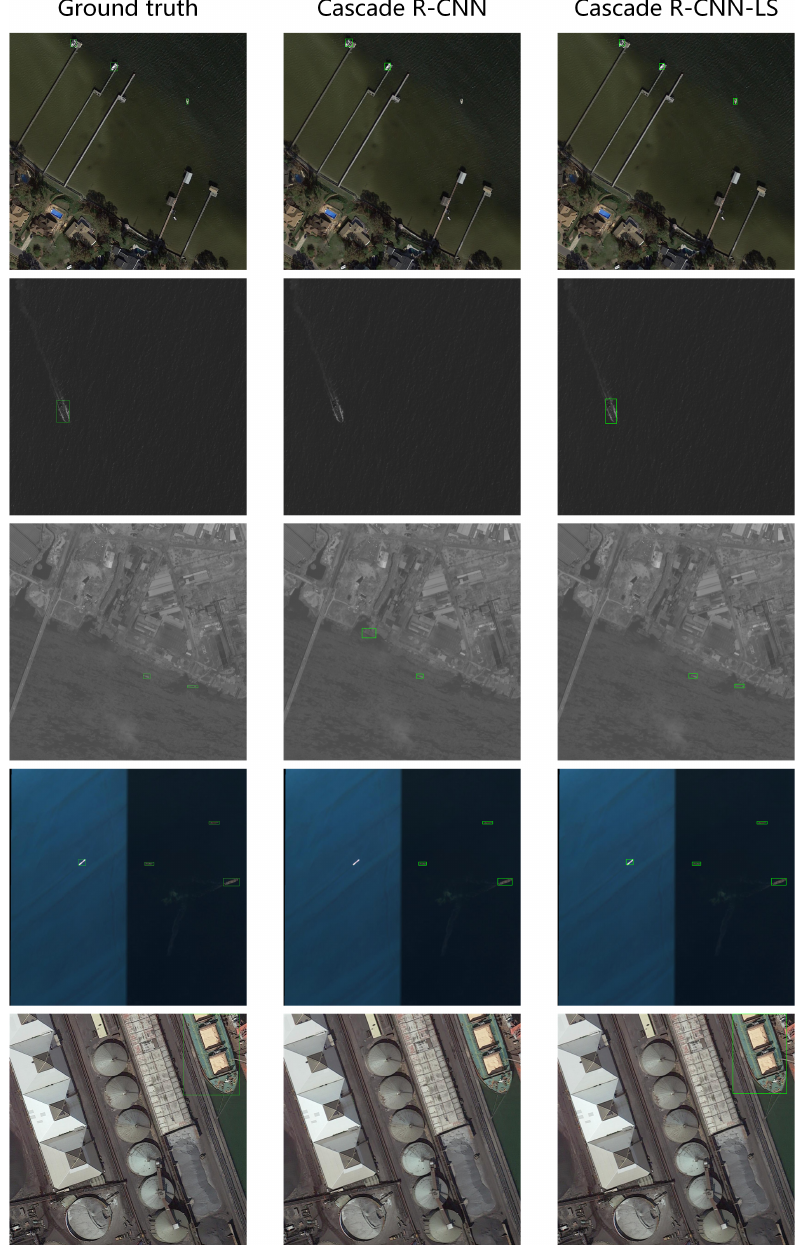
Figure 8. Detection results on DOTA-ship samples. The 1st column displays the samples from the ground truth, while the 2nd and 3rd columns are the detection results of the relative samples of Cascade R-CNN and Cascade R-CNN-LS, respectively. The lifting scheme-based network detects targets correctly in these samples, while Cascade R-CNN fails to detect some small, middle, and large size targets and has false